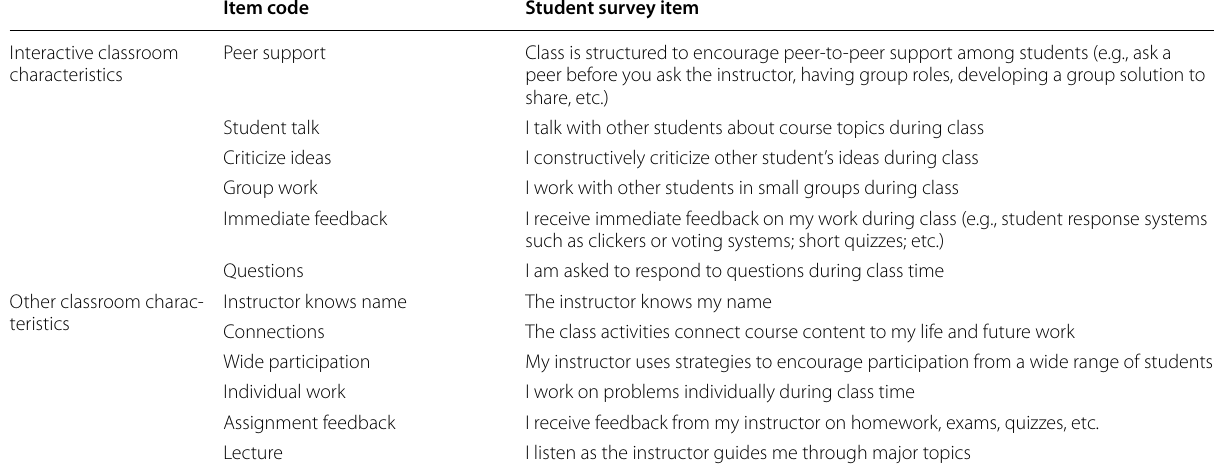
Table 1 Classroom characteristic statements, categorized into Interactive Classroom Characteristics and Other Classroom